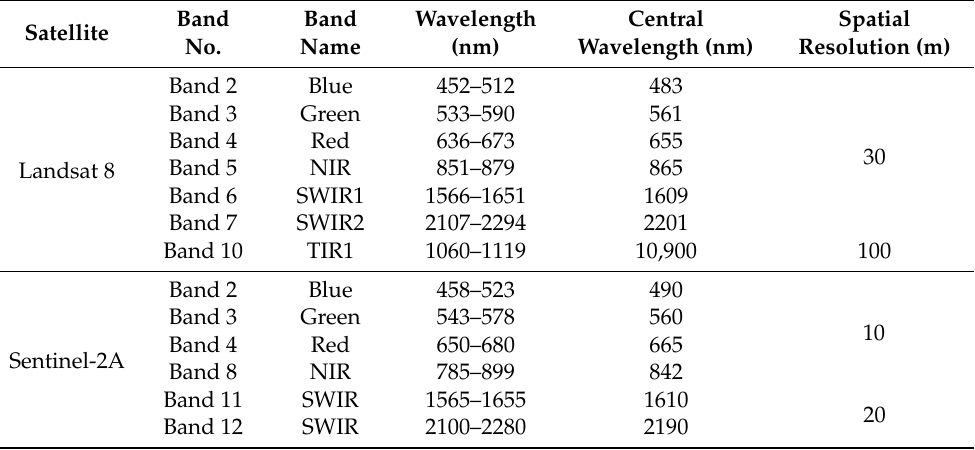
Table 1. Band parameters of the selected Landsat 8 and Sentinel-2A images.